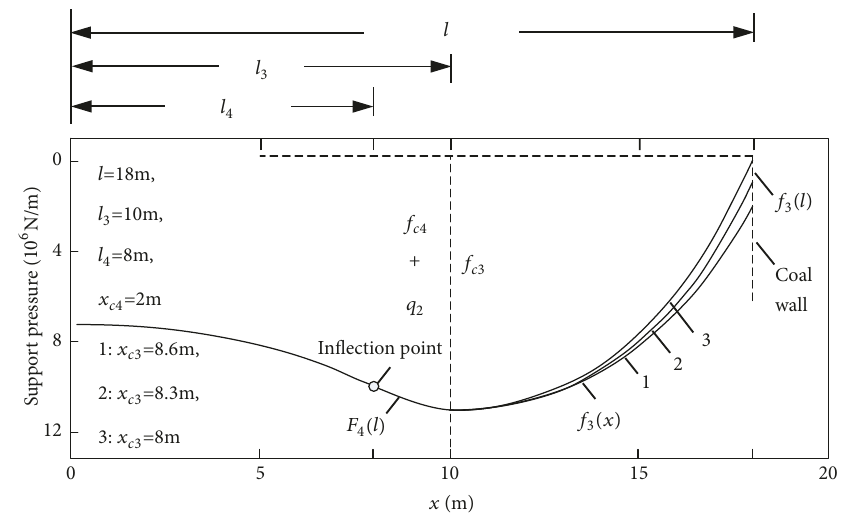
Figure 7: Schematic drawings of support pressure to roof in softened zone and hardened zone of coal